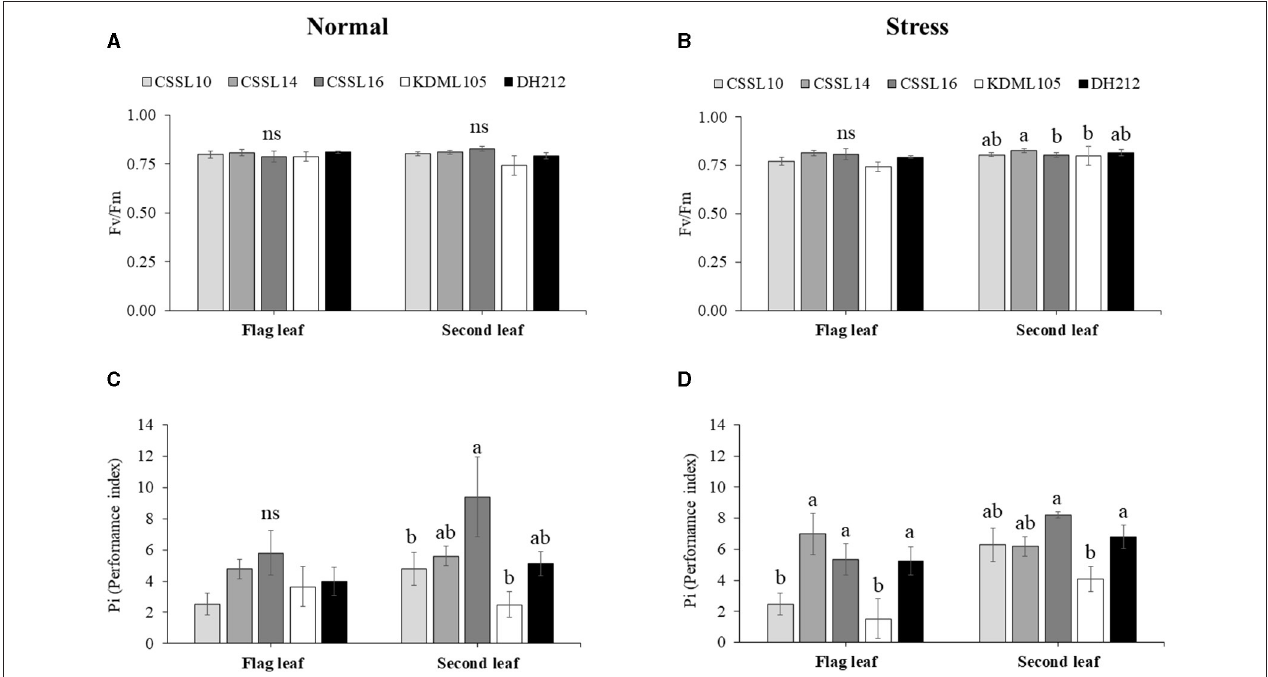
FIGURE 4 | Maximum PSII efficiency (F v /F m ) (A,B) and Performance index (Pi) (C,D) of flag leaves and second leaves in CSSL10, CSSL14, CSSL16, “KDML105.” and DH212 under normal and salt stress conditions. Values are represented as mean ± SE ( n = 4). Different letters above bars indicate significant difference between lines at p < 0.05. “ns” indicates no significant difference.